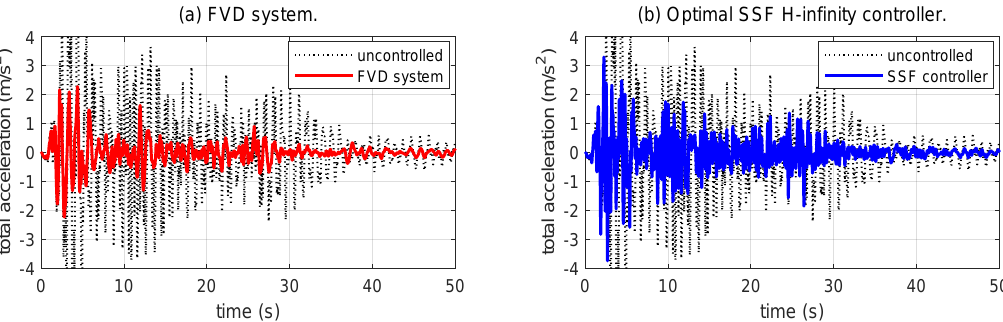
Figure 7. Close-up view of the interstory-drift time-response r 3 ( t ) for the FVD system and the optimal SSF H ∞ controller. The black dotted line in the background represents the clipped response of the uncontrolled building.